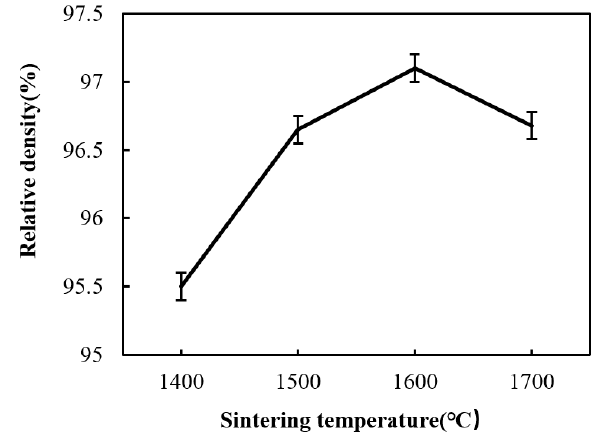
Figure 2. The relationship between the relative density and sintering temperature (holding for 10 min).